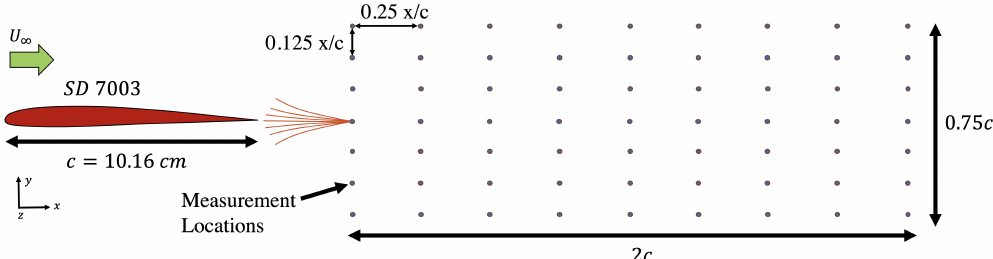
Figure 11. Downstream measurement grid locations in the wake of SD7003 wall-to-wall model.